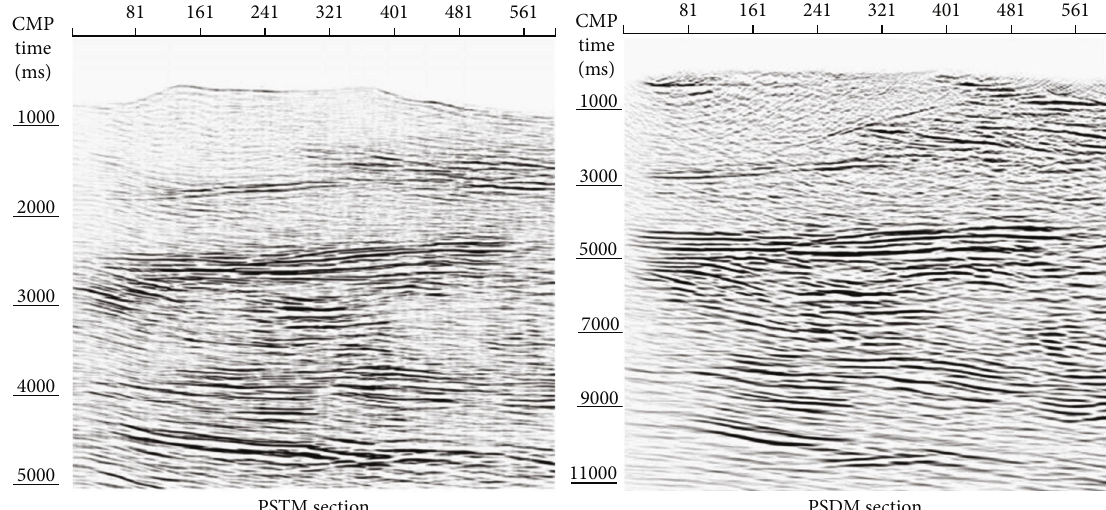
Figure 17: The sections processed by PSTM and PSDM (DK2019-4SN).